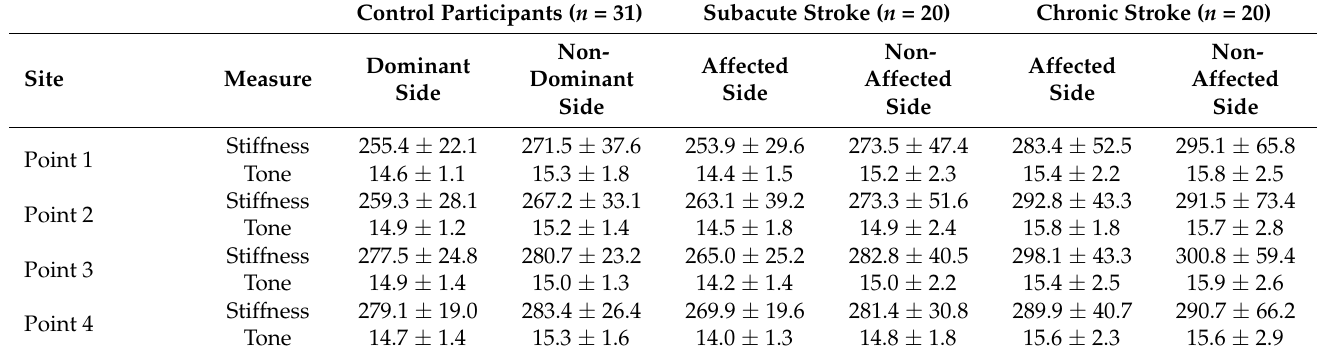
Table 3. Mean ± SD gastrocnemius muscle stiffness (N/m) and tone (Hz) over assessed sites (points 1 to 12, MB and MT sites) in stroke patients and